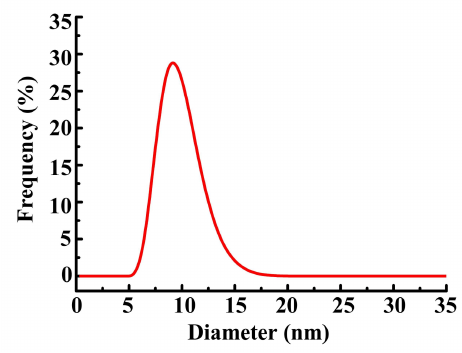
Figure 4. DLS of the polymer 2 , showing the diameter of around 9